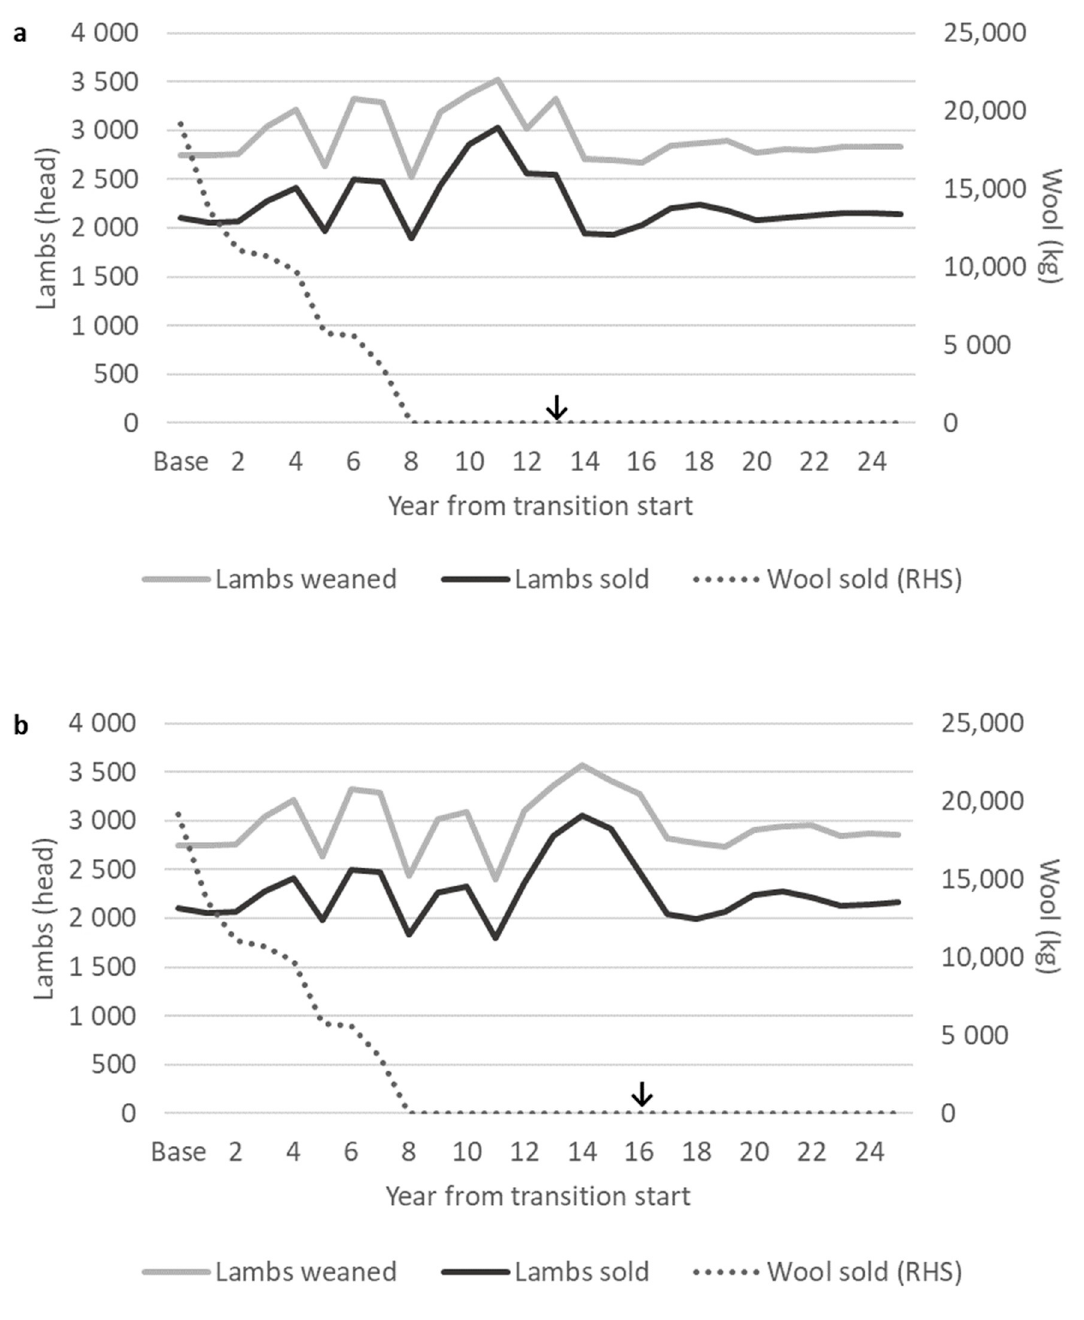
Figure 6. Total lambs weaned, sold, and wool sold during a grading up transition from base Romney to a desired final cross of either ( a ) 7 / 8 W 1 / 8 R or ( b ) straightbred. RHS = right hand side vertical axis. ↓ Where the grading up transition period has finished and the desired final cross flock ( ⅞ W ⅛ R or straightbred) has reached an equivalent feed demand to the base Romney